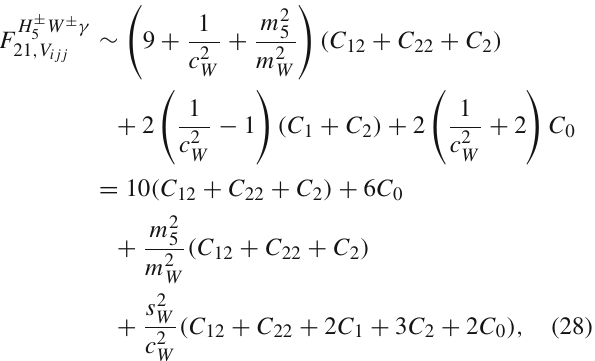
In contrast, the loop structure of a heavy gauge boson F 21 , VVV